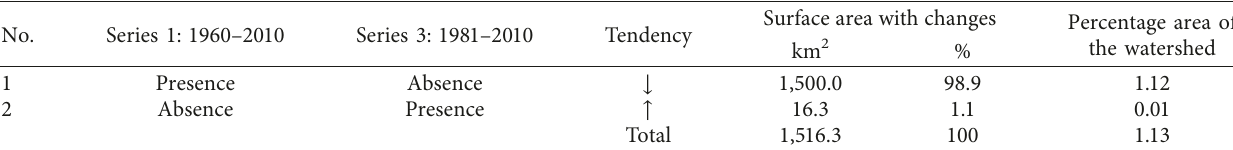
Table 6: Absolute, relative, and proportional areas of the Lerma-Chapala-Santiago watershed with changes in the presence or absence of mid-summer drought between time series one (1960–2010) and time series three (1960–1989).